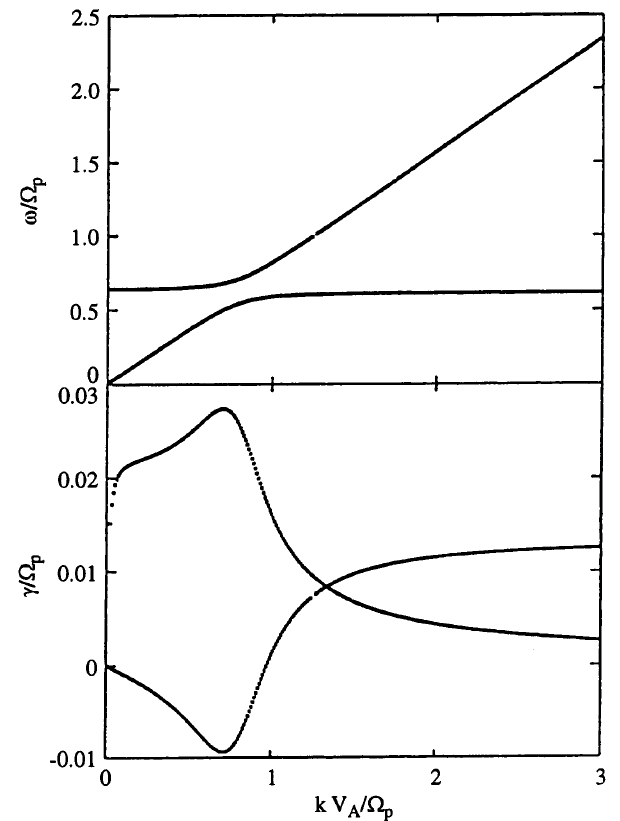
Fig. 6. Perpendicular propagating unstable extraordinary mode forced by an open nongyrotropy of alpha particles embedded in a gyrotropic electron-proton plasma (Motschmann and Glassmeier, 1998a)